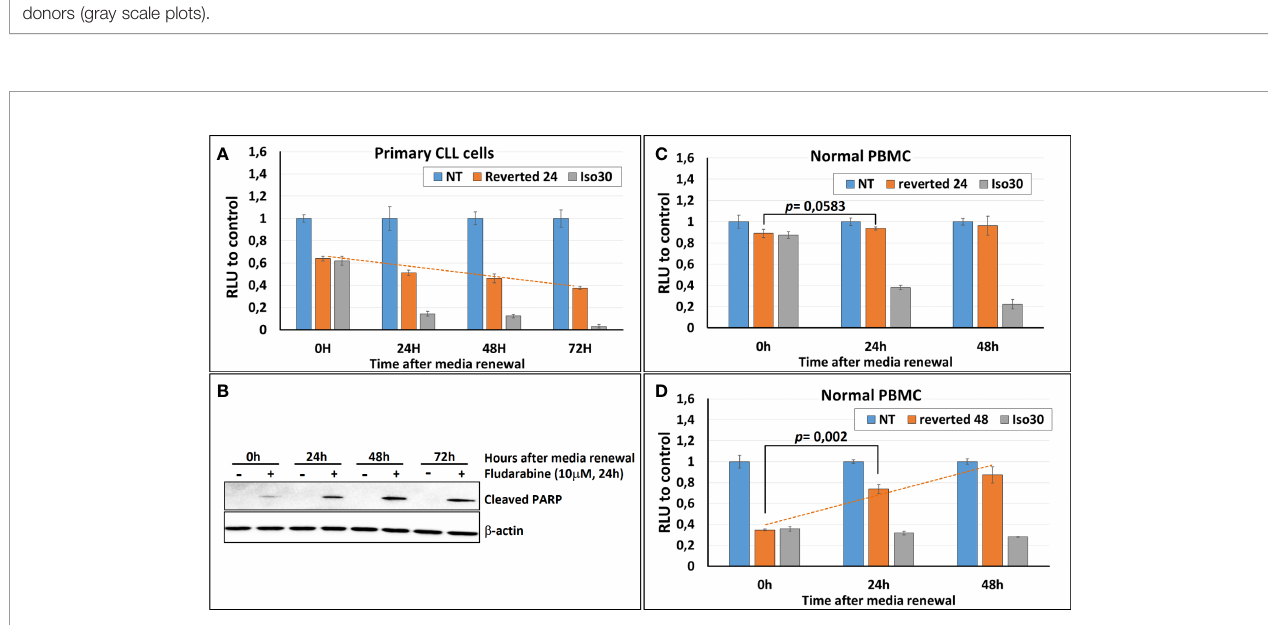
FIGURE 7 | Isoprenaline-effect on intracellular ATP content is irreversible in CLL primary cells. (A) Isoprenaline induced a long-lasting intracellular ATP depletion. The concentration of intracellular ATP in CLL primary cells was measured over 72 h in: i) non-treated cells (blue bars), ii) cells treated with Isoprenaline for only 24h then Isoprenaline was removed by cell wash and cells were maintained in Isoprenaline-free media (orange bars), or iii) in cells permanently treated with Isoprenaline (gray bars). Concentrations of intracellular ATP at the different time points were normalized to the respective negative control (non-treated cells). (B) Primary CLL cells were treated with Isoprenaline for only 24h then Isoprenaline was removed by cell wash and cells were maintained in Isoprenaline-free media, fl udarabine (10 m M) was added at different time points after Isoprenaline removal (0, 24, 48 and 72h). Primary CLL cells were incubated with fl udarabine for 24h then fl udarabine cytotoxic effect was assessed through quanti fi cation of the apoptotic marker (cleaved PARP). Full-length blots/gels are presented in Supplementary Figure 10 . (C) Normal PBMC were treated as in (A) . (D) Normal PBMC were treated as in (A) except that media was renewed after 48 hours instead of 24